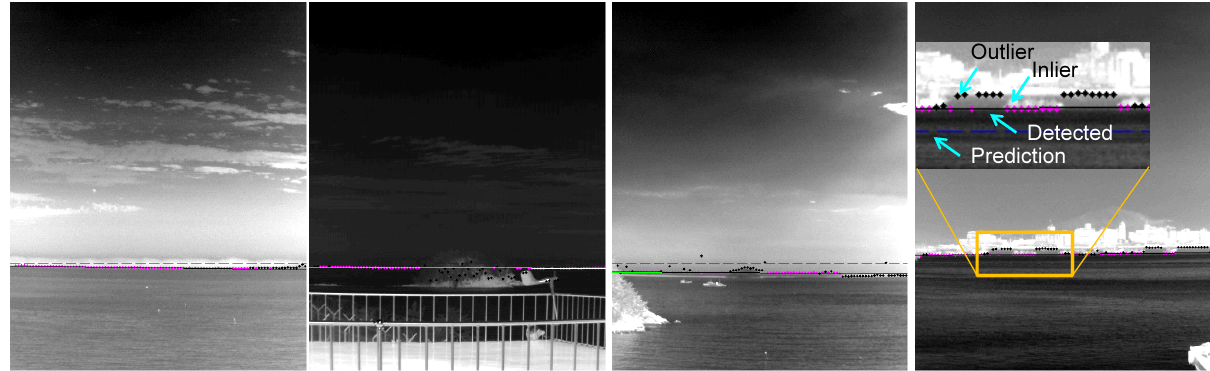
Figure 23. Examples of horizon detection for the test Sets